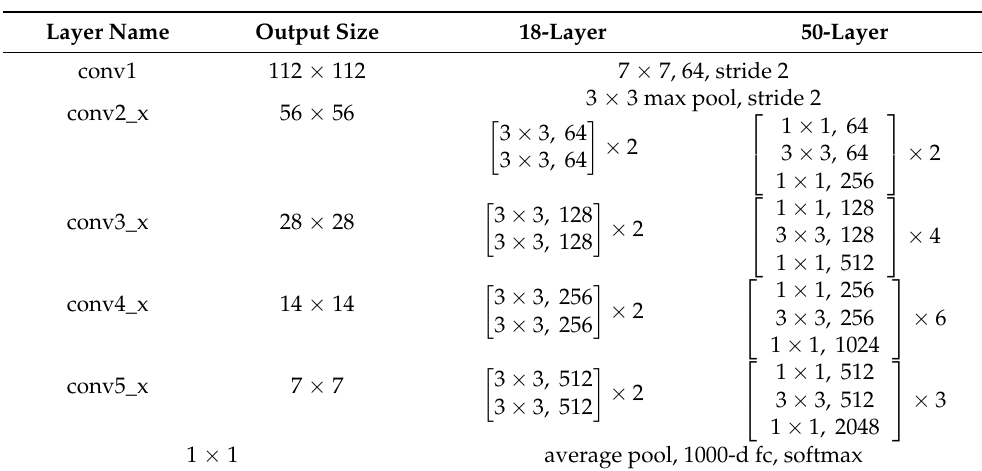
Table 2. ResNet architectures with different